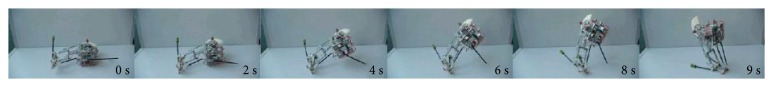
Self-righting process of a jumping robot designed by Zhang et al. [16].